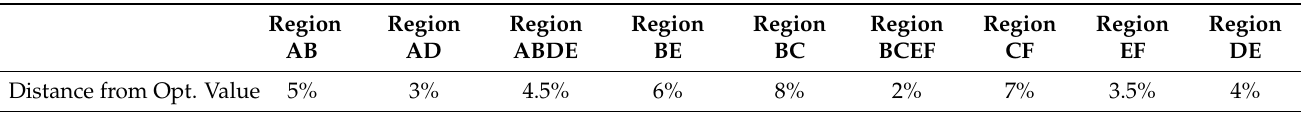
Table 1. Distribution of 0s and 1s in response bits at each border region and their distances from the optimal